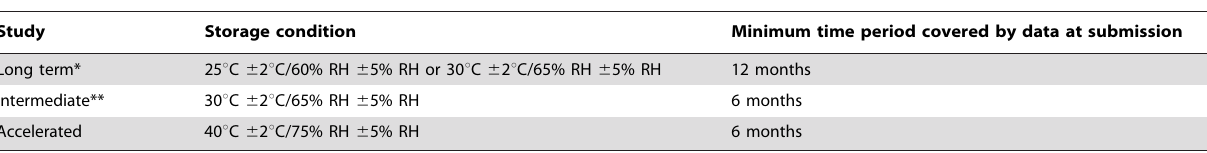
Table 1. Storage conditions requested by guideline ICH Q1A for the development of new drug products.